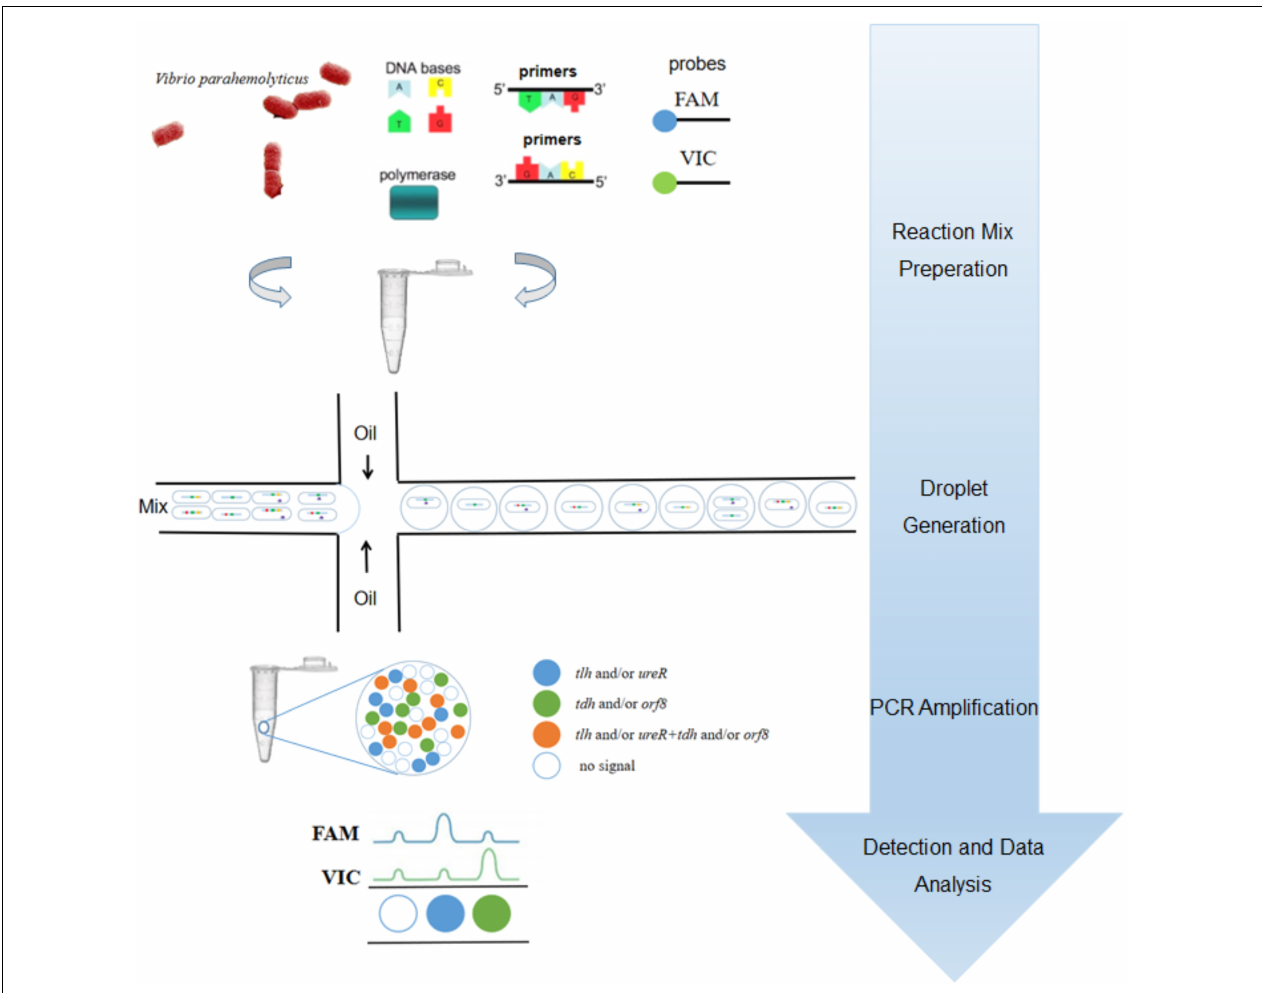
FIGURE 1 | The procedural framework of the 4-plex ddPCR for specific detection of intact V. parahaemolyticus cells. The bacterial solution containing intact cells were added to the PCR reaction. The cells were dispersed into droplets prior to PCR-amplification. The targets of tlh (green), tdh (red), ureR (yellow), and orf8 (purple) were determined based on fluorescent